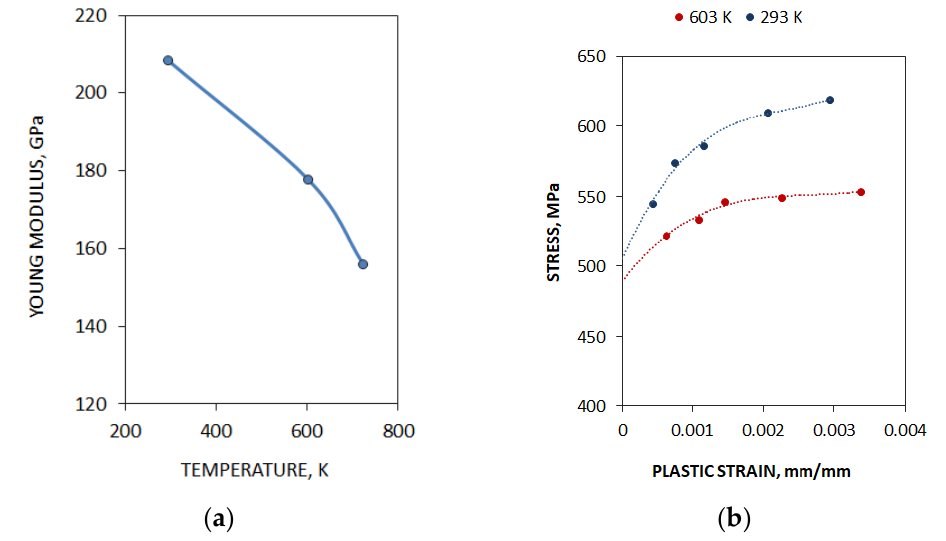
10 of 19 Figure 7. Time-dependent temperature differences between the internal and external surfaces at the middle bottom of the boiler drum for the considered startup scenarios. 4.2. Mechanical Analysis The time-dependent stress and strain components were calculated for the OR